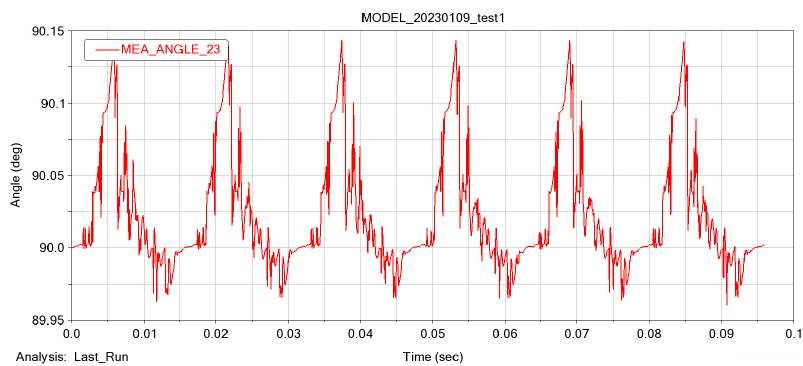
Figure 30. Torsional vibration of the third crank. To obtain the torsional vibration of the crankshaft under different working conditions, different rotational speeds are applied to the crankshaft, and the results are shown in Figures 31 and 32.